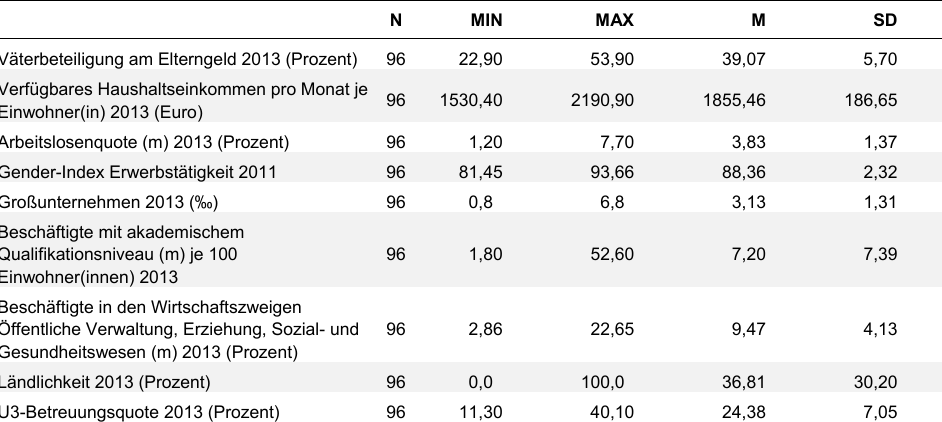
Tabelle 1 : Deskriptive Statistik der